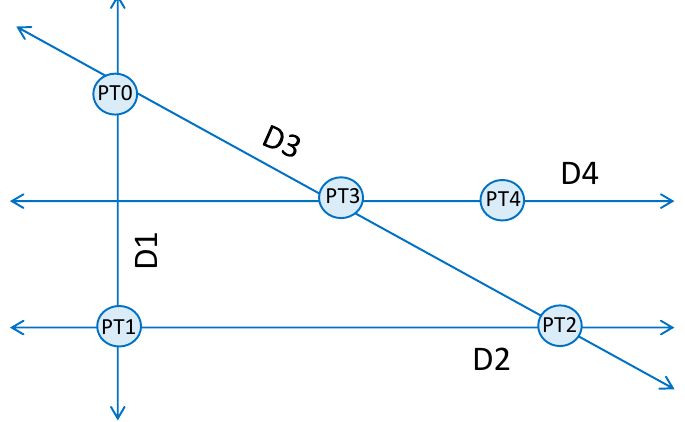
Figure 5. Depiction of the first four searches in Powell’s method. An initial point (PT0) is chosen in the 2-D search space. A search is performed in the vertical direction, D1, locating the maximal selectivity at PT1. Point PT1 becomes the starting point for a search orthogonal to the first search in direction D2. The maximal selectivity of the second search is found at PT2. The third search is performed in the direction connecting points PT0 and PT2, direction D3, and resulting in a new maximum PT3. The search continues with another horizontal search parallel to D2 and intersecting PT3; a subsequent search is performed in the direction that connects the newly found point, PT4, to PT2. The algorithm iterates until the search goal reached.